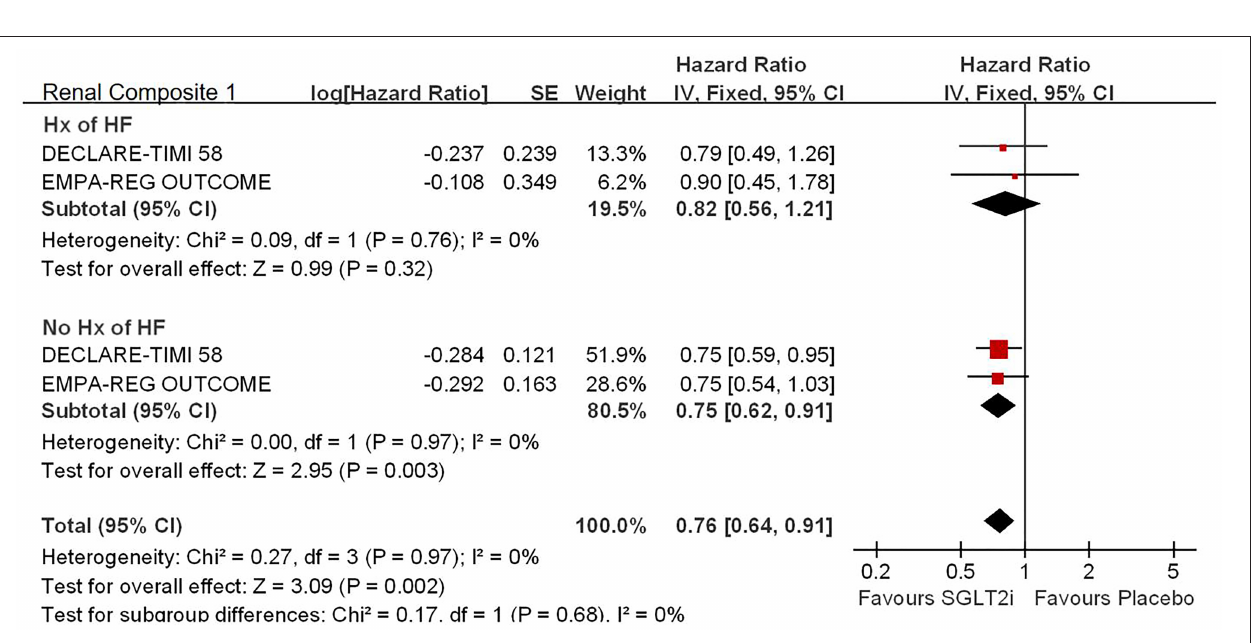
FIGURE 4 | Subgroup analysis of meta-analysis on HHF by eGFR